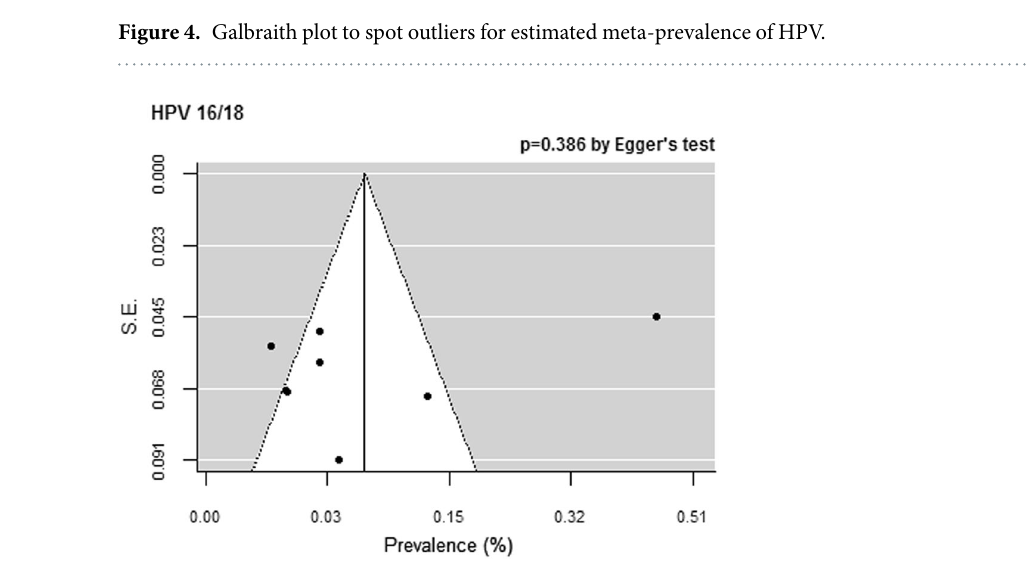
Figure 5. Publication bias for the prevalence of PCR-detected HPV infection. Funnel plots for HPV 16/18. The black square signifies the weighted mean of each estimate. All data provided are for continuous